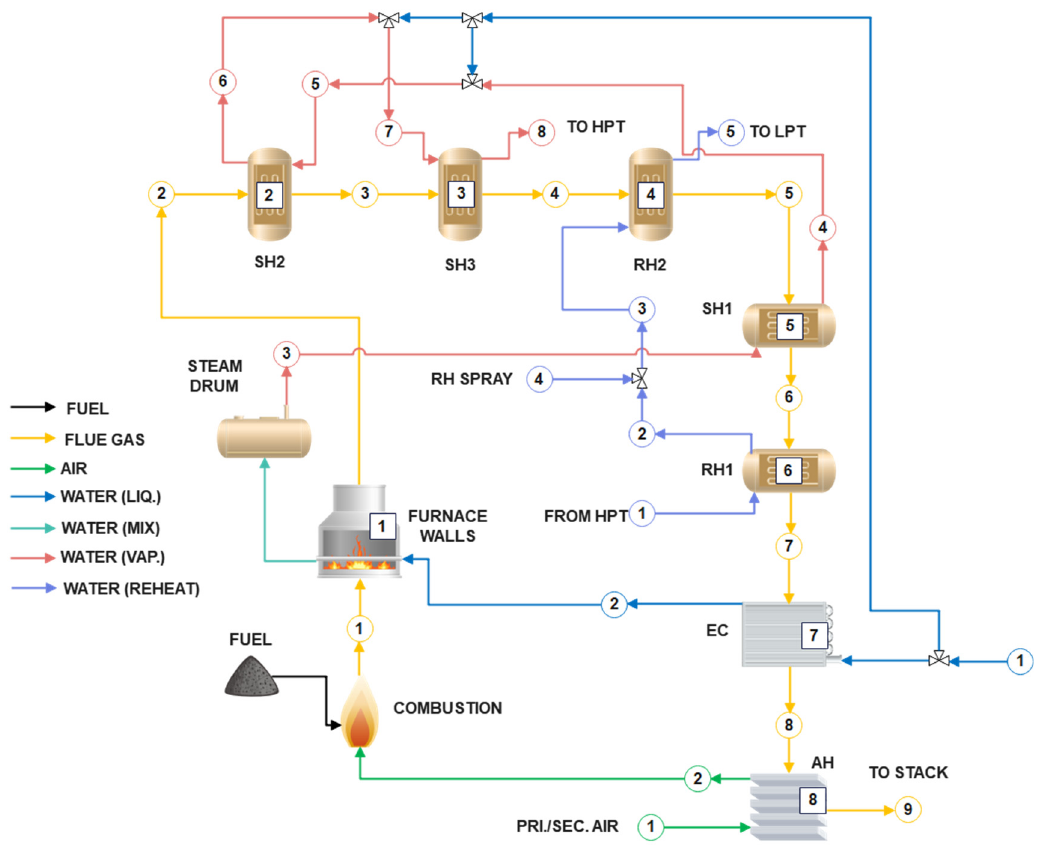
Figure 6. Process flow diagram of utility-scale coal-fired boiler model.